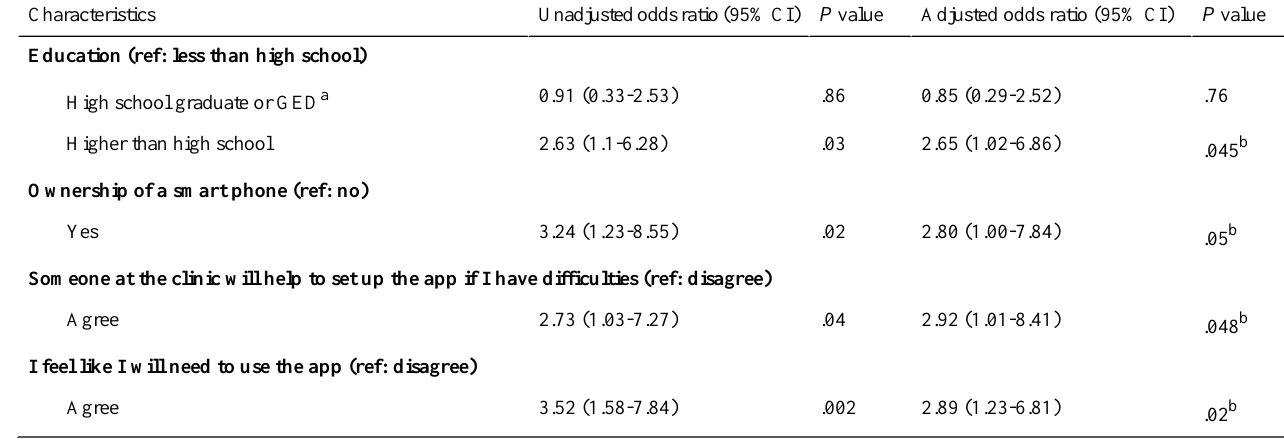
Table 3. Multivariate correlations between baseline characteristics and adoption of the mobile health platform to improve antiretroviral therapy adherence among people living with HIV/AIDS (PLWH) by multivariable analysis in the Florida mHealth Adherence Project for PLWH Study, 2015-2016